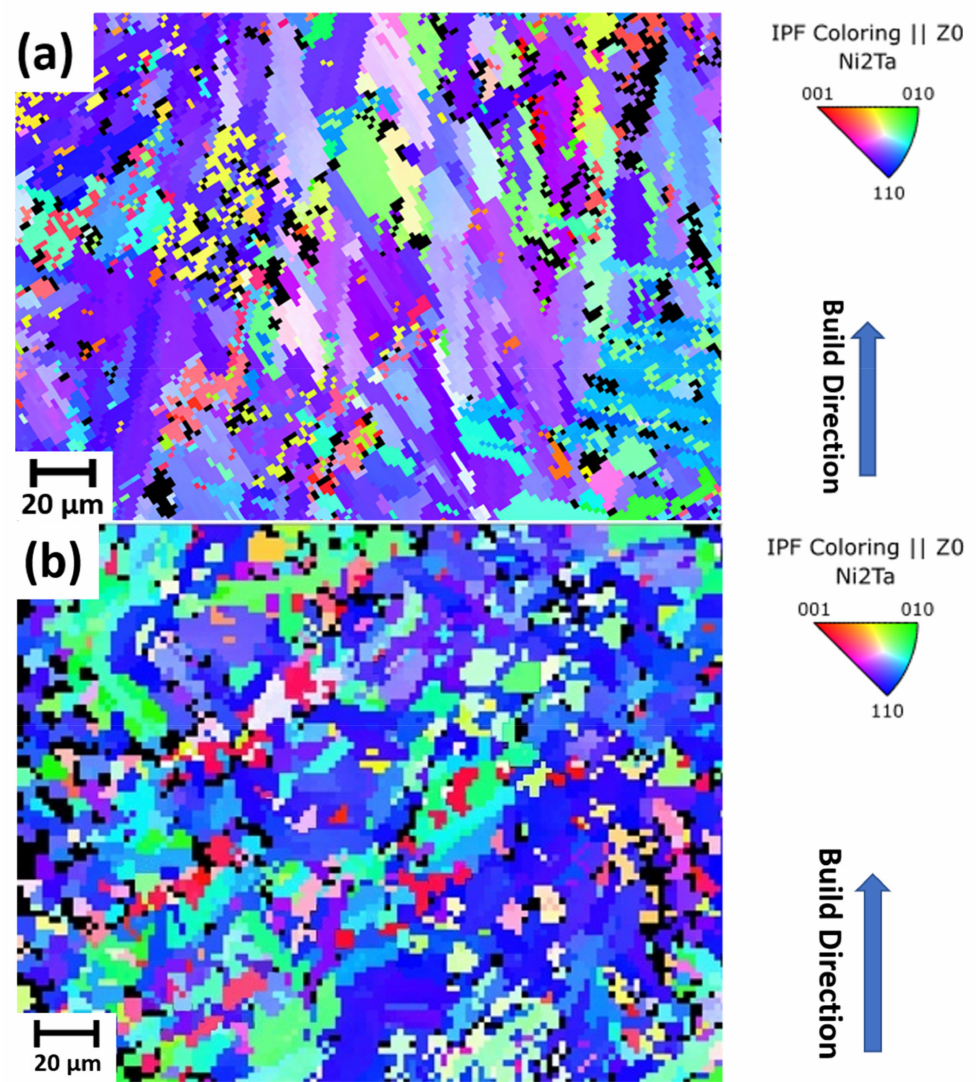
Figure 15. EBSD inverse-pole-figure maps of the ( a ) as-fabricated and ( b ) case 6 specimens on the sagittal